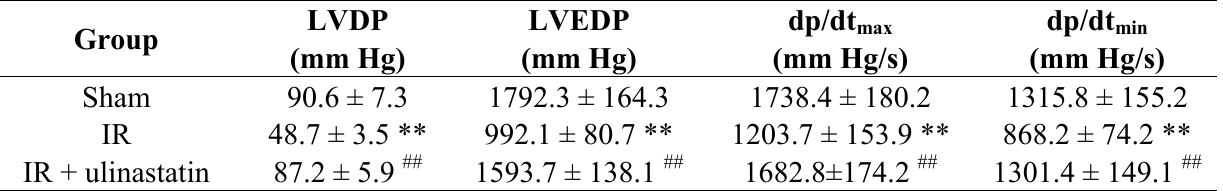
and dp/dt in three max min